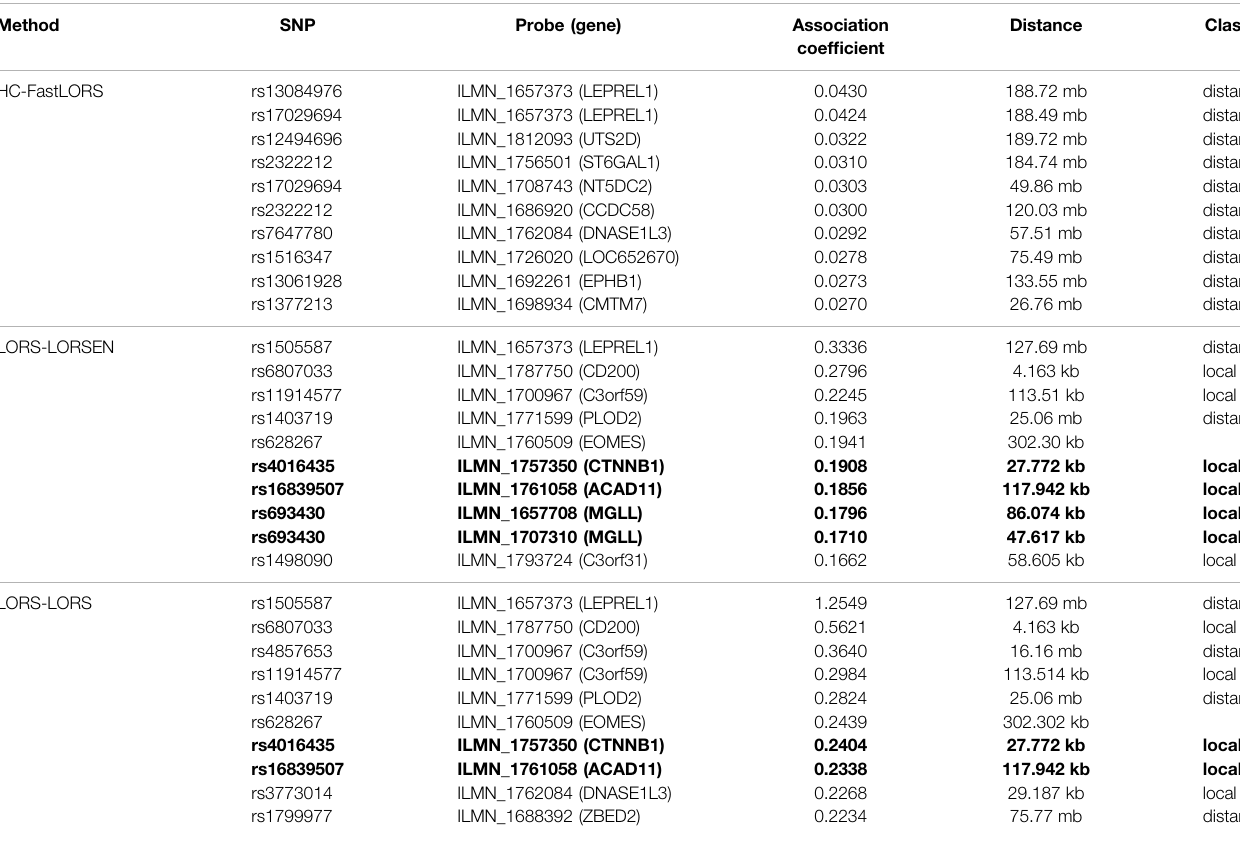
TABLE 7 | Top ten detected SNP-probe pairs for chromosome 3. The SNP-probe pairs that are con fi rmed in seeQTL database are in bold. Method SNP Probe